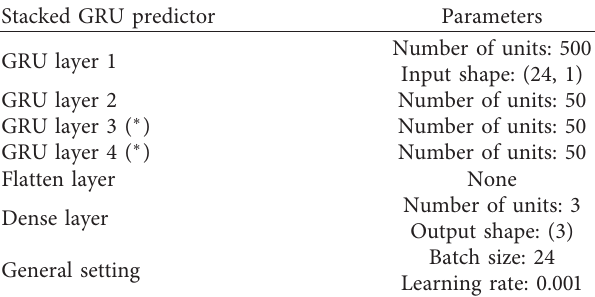
Figure 9: The RMSE results of determining network parameters. (a) Search for 2-layer network. (b) Search for 3-layer network. (c) First search for 4-layer network. (d) Second search for 4-layer network. Table 5: Parameters of the proposed